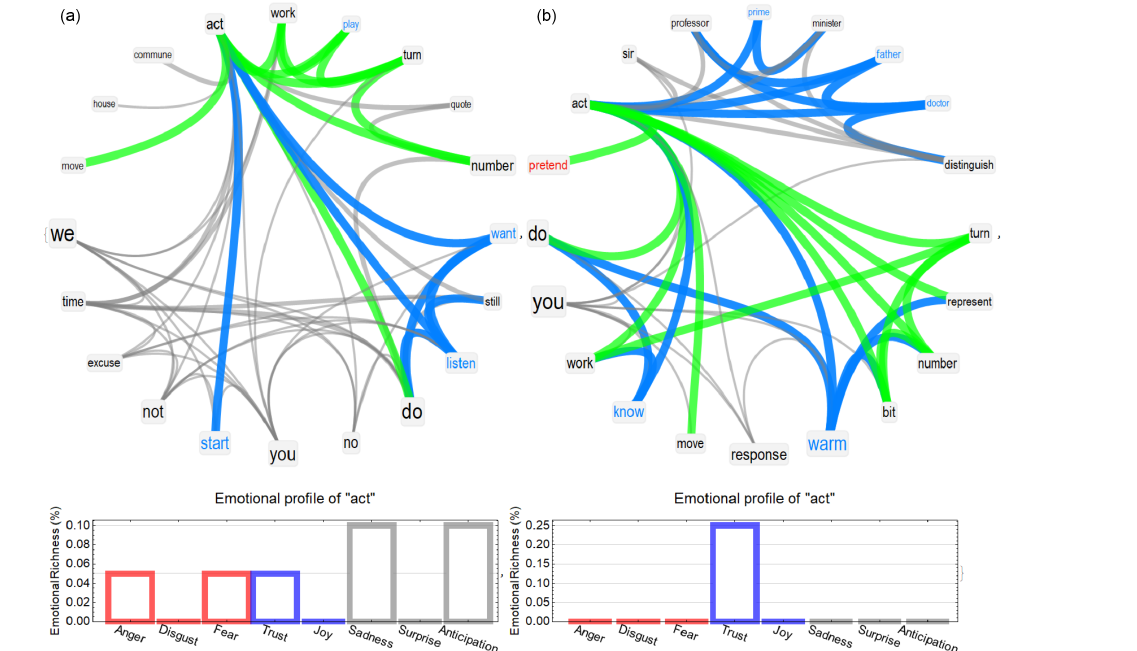
Figure A10. Speakers’ mindset reconstruction around “act” in the speeches of Greta Thunberg (a) and Christopher Monckton (b) . We refer the reader to Fig. 1 for a detailed explanation of the colour code and to Lexicon 1 for an interpretation of the figure.